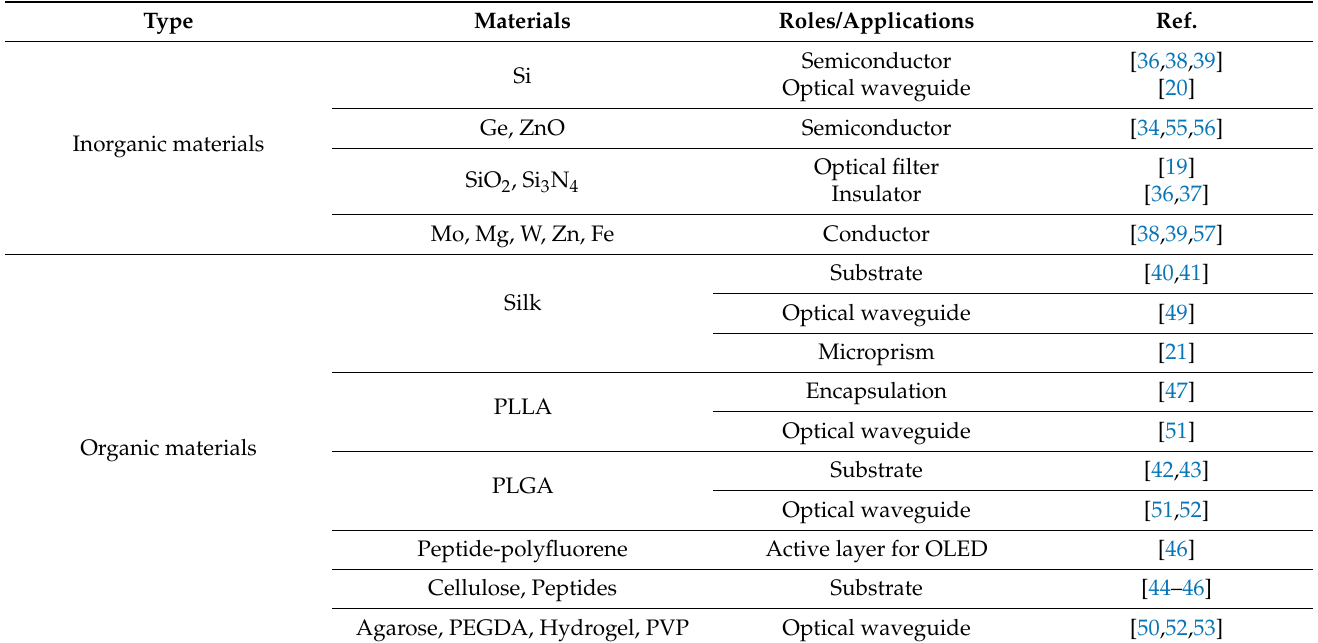
Table 1. Commonly used bioresorbable optical materials and their roles/applications for the construction of devices. Type Materials Roles/Applications Ref.